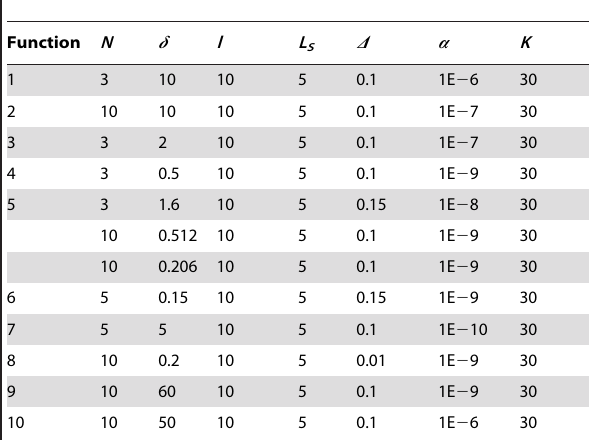
Table 1. Parameter setting of the functions for the IPMA.